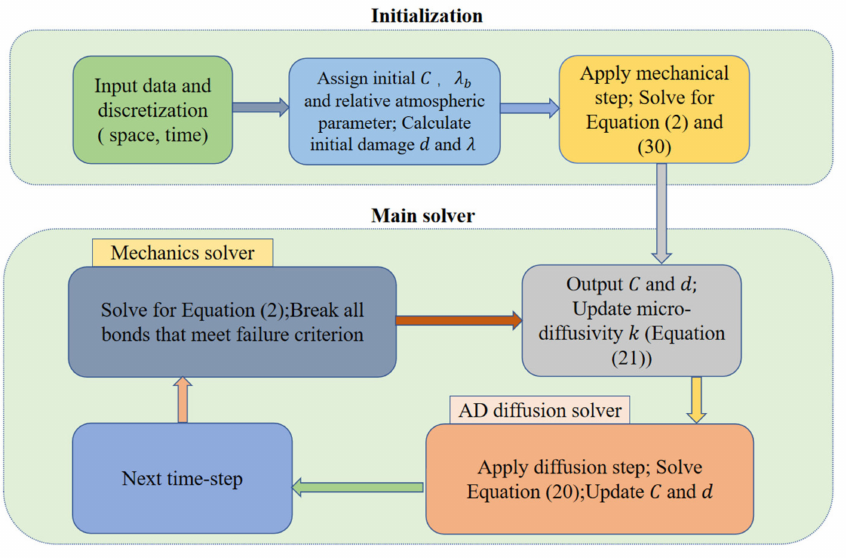
Figure 4. Graphical illustration of the coupled peridynamic atmosphere corrosion–fracture